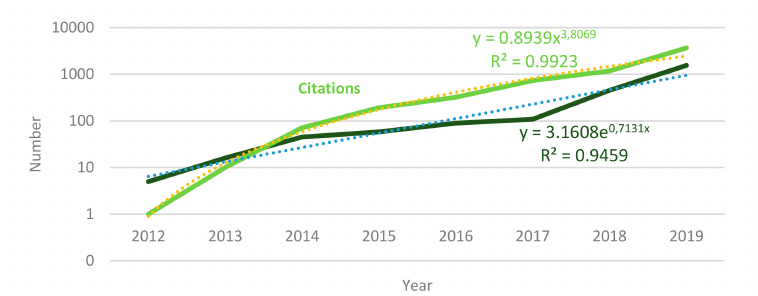
Figure 6. Distribution of published documents and citations per year on a logarithmic scale.